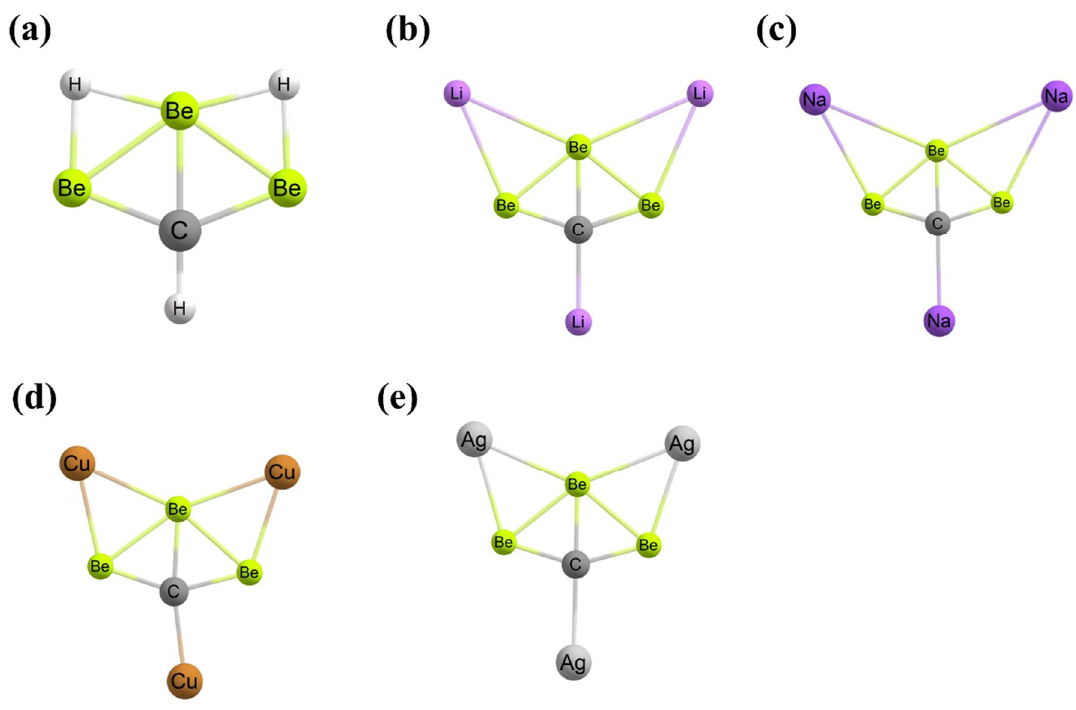
Figure 12. The global minimum structures of ( a ) CBe 3 H 3+ , ( b ) CBe 3 Li 3+ , ( c ) CBe 3 Na 3+ , ( d ) CBe 3 Cu 3+ , and ( e ) CBe 3 Ag 3+ clusters.